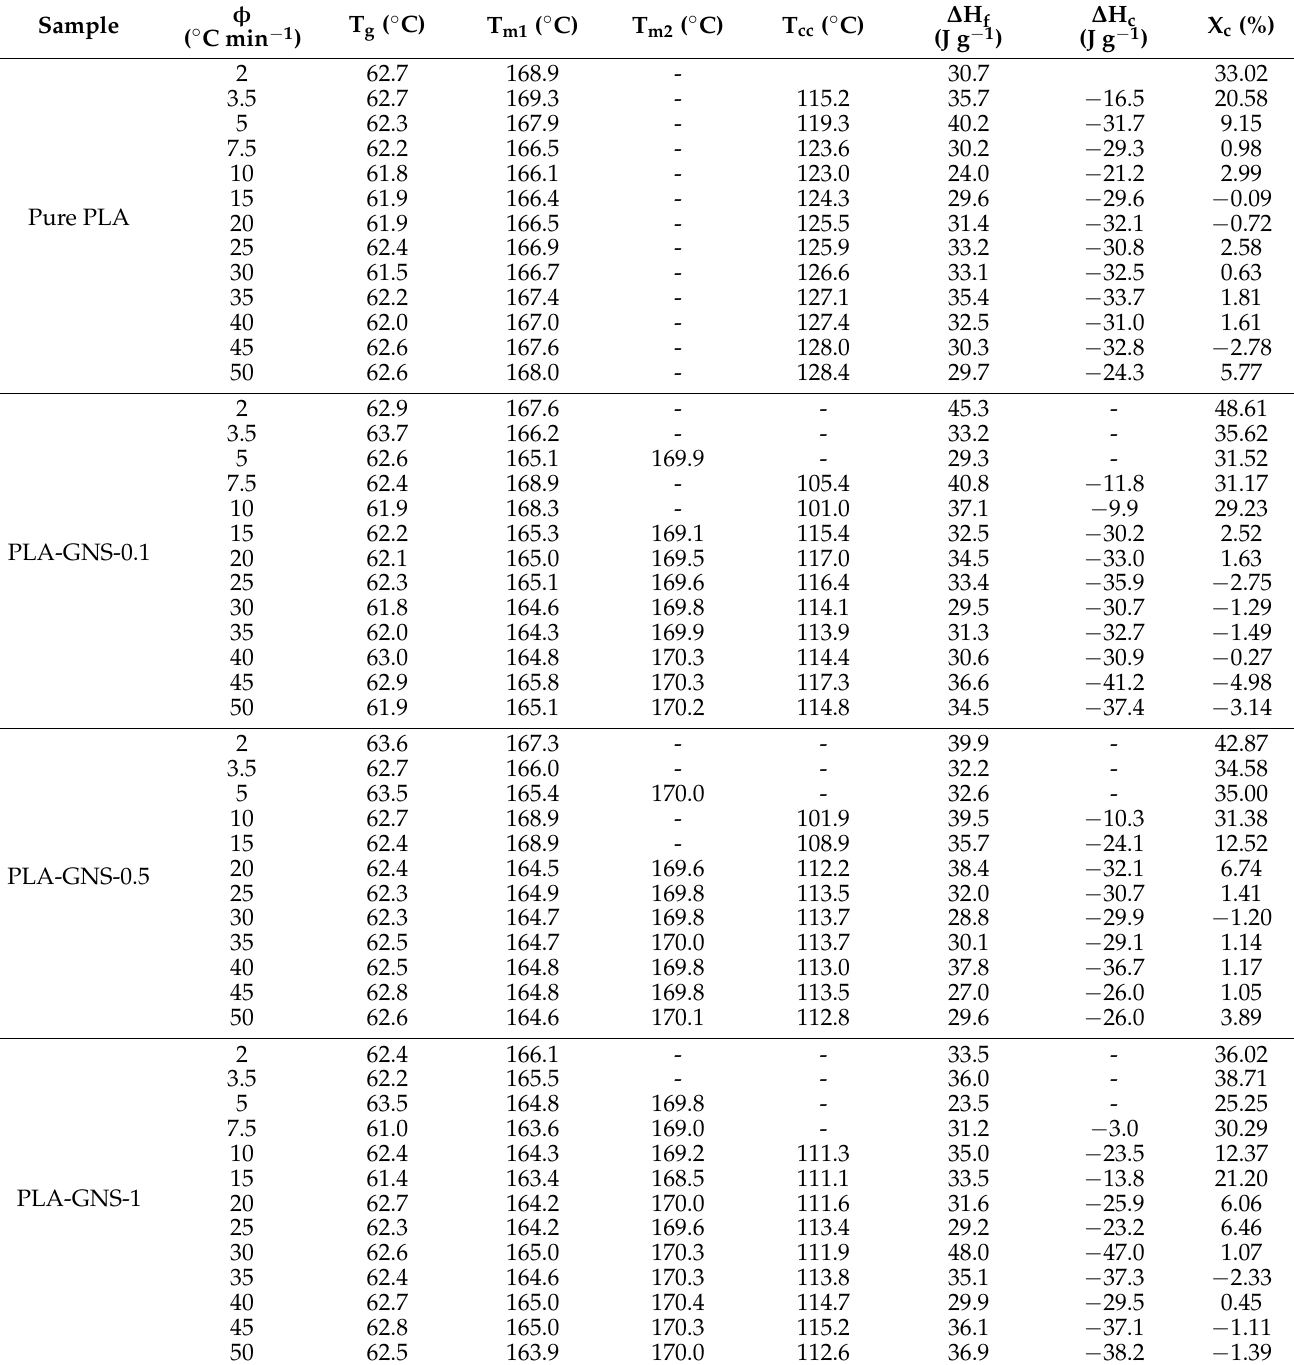
Table 2. Thermal parameters of pure PLA and PLA-GNS nanocomposites at different cooling rates.